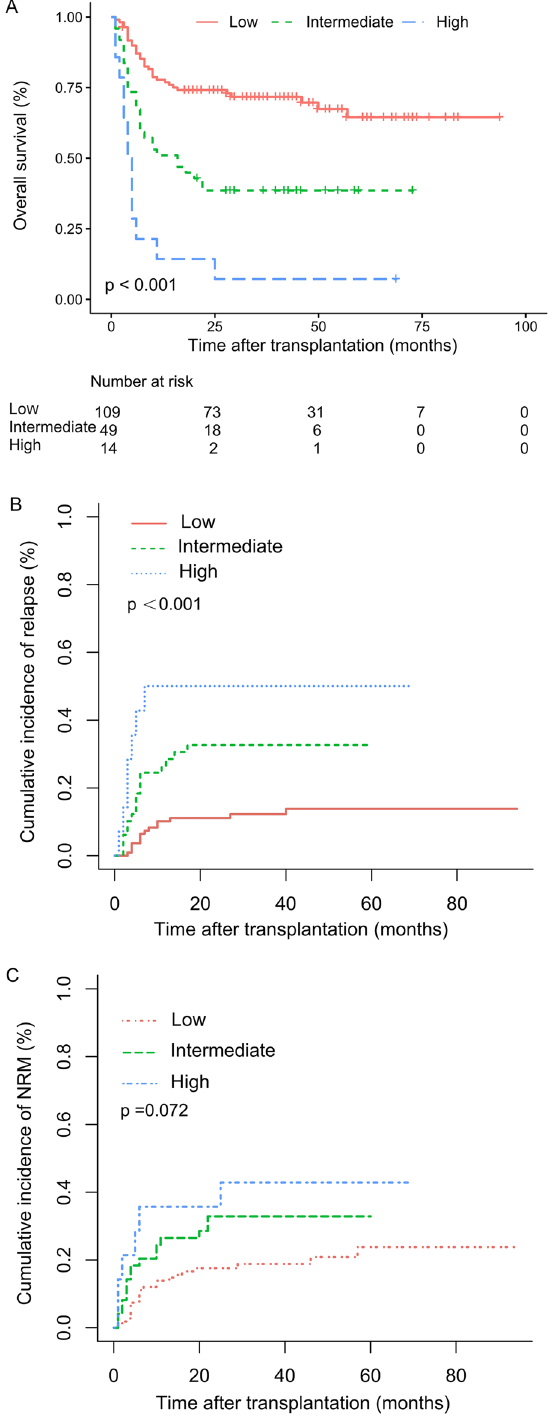
Figure 1. Comparison of overall survival ( A ), cumulative incidence of relapse ( B ) and cumulative incidence of NRM ( C ) by the AML-DRG model in patients with low-, intermediate- and high-risk